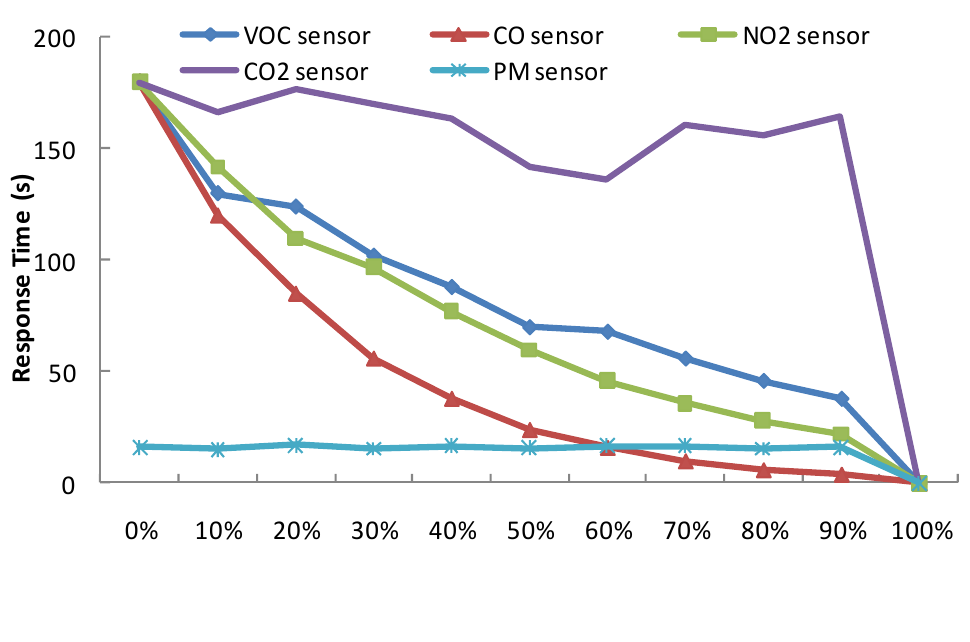
Figure 10. Correlation between sensors’ duty cycles and their response times. In the case of semiconductor sensors, average response time is lowered as the duty cycle becomes